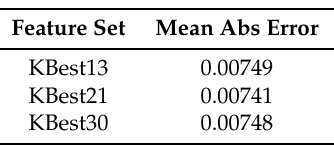
Table 2. Mean absolute error for three different feature sets when using the random forest algorithm and the 10-fold cross-validation test strategy.